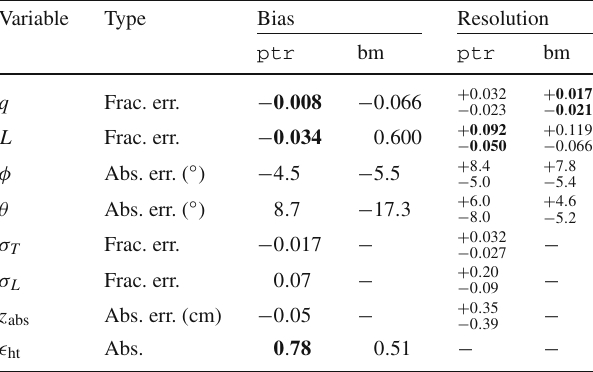
Table 1 Performance summary for the key primary track properties using simulated tracks at the standardized working point (SWP). The first column indicates the measured track property. The second col- umn indicates the type of quantity shown: “frac. err.” is the fractional error ( x − x truth )/ x truth for a variable x , “abs. err.” is the absolute error x − x truth , and “abs.” is simply x . The next columns show the bias (most probable value of the error) and resolution (single-sided standard devi- ation of the error) for ptr and for the benchmark method (bm). We indicate quantities that are significantly better for a particular method with boldface. In the case of the head-tail efficiency (cid:8) ht , we additionally consider θ truth = 45 ◦ tracks in order to balance the asymmetric